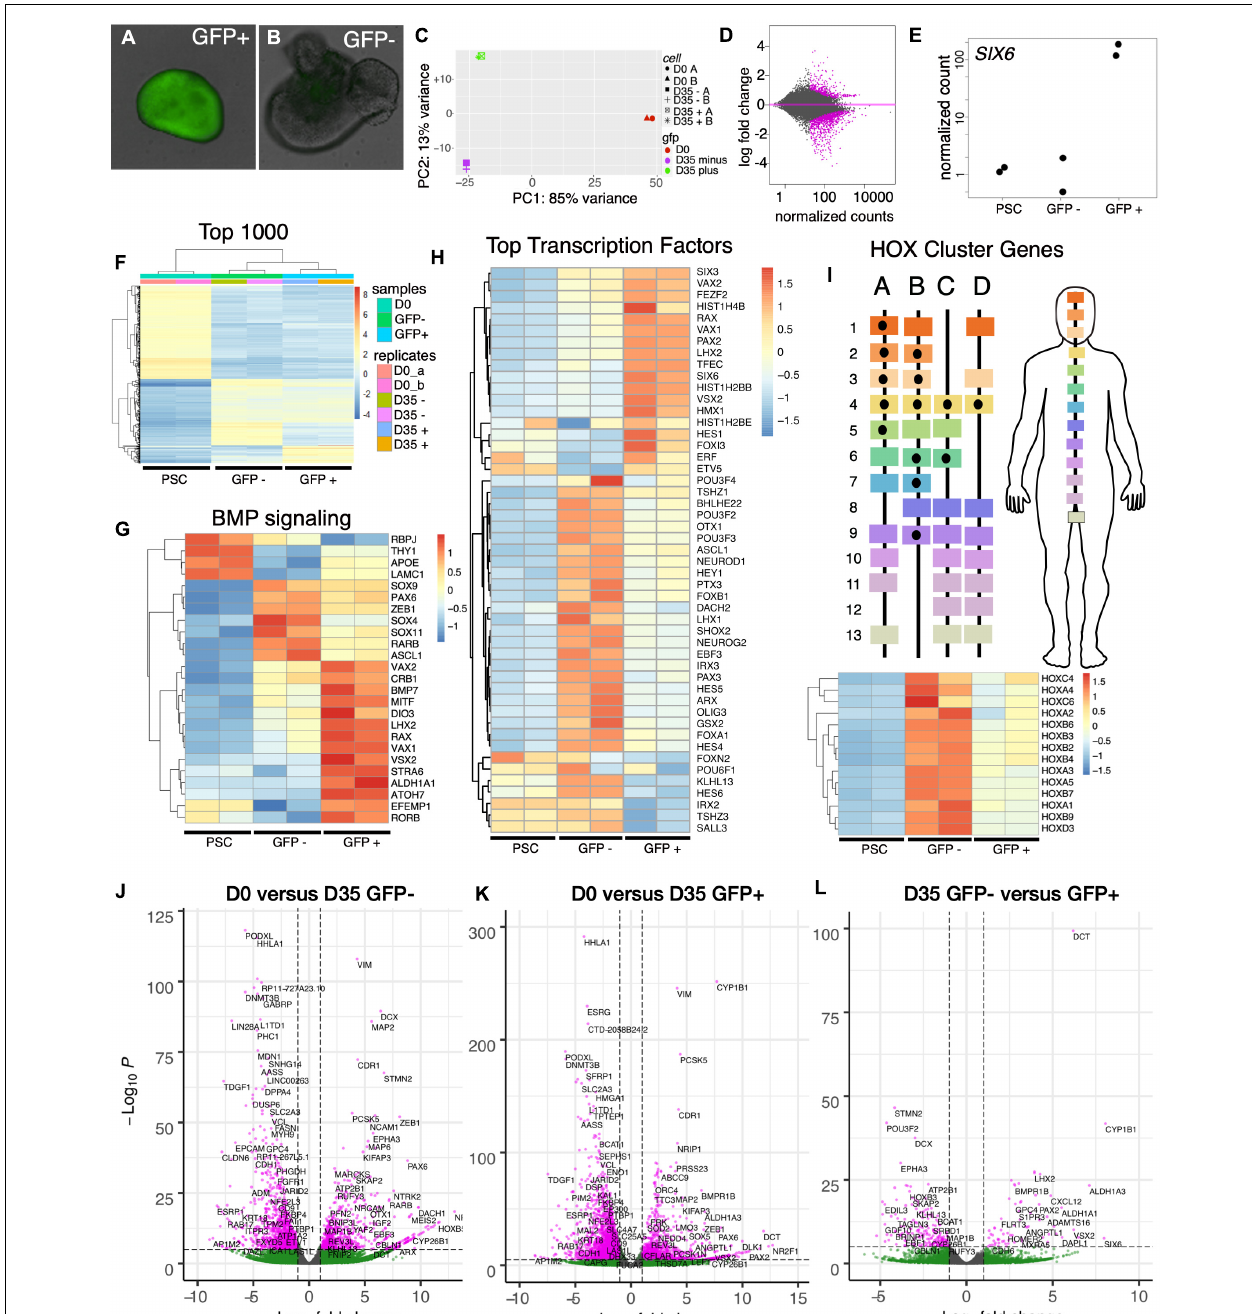
FIGURE 5 | Transcriptional profiling of SIX6-GFP positive and negative neural vesicles. Analysis of undifferentiated IMR90.4 PSCs (day 0) and pooled SIX6-GFP + and - organoids (day 35) differentiated under conditions that promote anterior neural development. (A,B) SIX6-GFP + or – organoids imaged at D27 were pooled ( n = 12) and RNA extracted at D35. (C) Principal component analysis (PCA) of undifferentiated PSCs (red), D35 SIX6-GFP positive (green), and D35 SIX6-GFP negative (magenta) organoids showing tight clustering between replicates. (D) MA-plot highlighting genes with altered expression (magenta). (E) Normalized counts of SIX6 expression in PSCs and SIX6-GFP + or - organoids. (F) A heat-map of the top 1,000 genes in PSCs and D35 organoids showing clustering of genes between replicates and differences between PSCs and vesicles (GFP + and –). (G) Ingenuity Pathway analysis (IPA) of genes linked to BMP signaling and hierarchical clustering of the top 25 genes in this category. (H) The top 50 transcription factor genes that are differentially expressed in PSCs, optic vesicles, and presumptive forebrain. (I) Homeobox (HOX) cluster gene enrichment in D35 SIX6-GFP negative organoids relative to PSCs and SIX6-GFP + vesicles. (J–L) Volcano plots showing transcriptional differences between (J) PSCs and D35 SIX6-GFP- organoids, (K) PSCs and D35 SIX6-GFP + organoids and (L) D35 SIX6-GFP- and + organoids with genes plotted that pass the thresholds of statistical significance (pCutoff ≤ 10e-6, and FCcutoff ≥ 1.0 log 2 ).